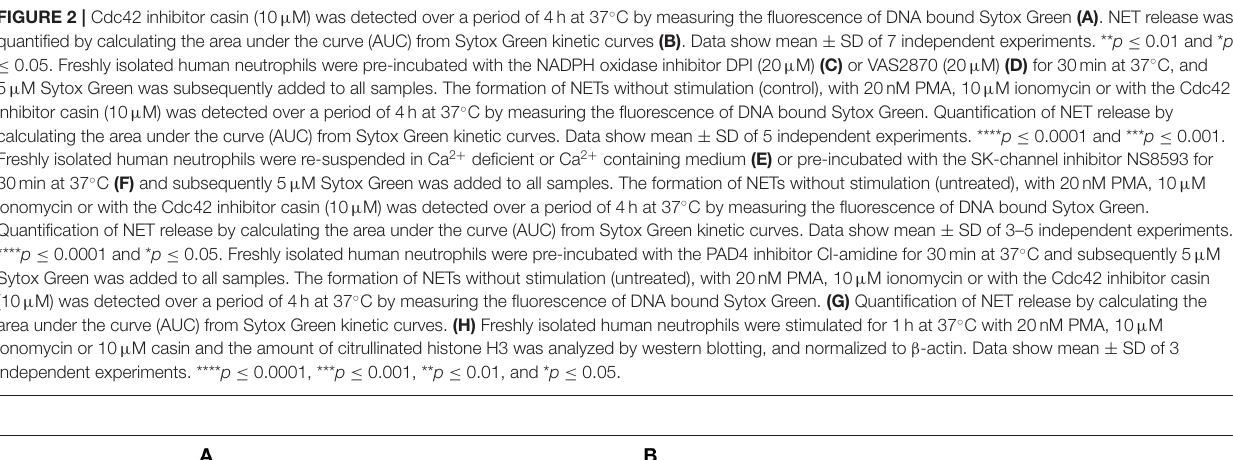
FIGURE 2 | Cdc42 inhibitor casin (10 µ M) was detected over a period of 4h at 37 ◦ C by measuring the fluorescence of DNA bound Sytox Green (A) . NET release was quantified by calculating the area under the curve (AUC) from Sytox Green kinetic curves (B) . Data show mean ± SD of 7 independent experiments. ** p ≤ 0.01 and * p ≤ 0.05. Freshly isolated human neutrophils were pre-incubated with the NADPH oxidase inhibitor DPI (20 µ M) (C) or VAS2870 (20 µ M) (D) for 30min at 37 ◦ C, and 5 µ M Sytox Green was subsequently added to all samples. The formation of NETs without stimulation (control), with 20nM PMA, 10 µ M ionomycin or with the Cdc42 inhibitor casin (10 µ M) was detected over a period of 4h at 37 ◦ C by measuring the fluorescence of DNA bound Sytox Green. Quantification of NET release by calculating the area under the curve (AUC) from Sytox Green kinetic curves. Data show mean ± SD of 5 independent experiments. **** p ≤ 0.0001 and *** p ≤ 0.001. Freshly isolated human neutrophils were re-suspended in Ca 2 + deficient or Ca 2 + containing medium (E) or pre-incubated with the SK-channel inhibitor NS8593 for 30min at 37 ◦ C (F) and subsequently 5 µ M Sytox Green was added to all samples. The formation of NETs without stimulation (untreated), with 20nM PMA, 10 µ M ionomycin or with the Cdc42 inhibitor casin (10 µ M) was detected over a period of 4h at 37 ◦ C by measuring the fluorescence of DNA bound Sytox Green. Quantification of NET release by calculating the area under the curve (AUC) from Sytox Green kinetic curves. Data show mean ± SD of 3–5 independent experiments. **** p ≤ 0.0001 and * p ≤ 0.05. Freshly isolated human neutrophils were pre-incubated with the PAD4 inhibitor Cl-amidine for 30min at 37 ◦ C and subsequently 5 µ M Sytox Green was added to all samples. The formation of NETs without stimulation (untreated), with 20nM PMA, 10 µ M ionomycin or with the Cdc42 inhibitor casin (10 µ M) was detected over a period of 4h at 37 ◦ C by measuring the fluorescence of DNA bound Sytox Green. (G) Quantification of NET release by calculating the area under the curve (AUC) from Sytox Green kinetic curves. (H) Freshly isolated human neutrophils were stimulated for 1h at 37 ◦ C with 20nM PMA, 10 µ M ionomycin or 10 µ M casin and the amount of citrullinated histone H3 was analyzed by western blotting, and normalized to β -actin. Data show mean ± SD of 3 independent experiments. **** p ≤ 0.0001, *** p ≤ 0.001, ** p ≤ 0.01, and * p ≤ 0.05.